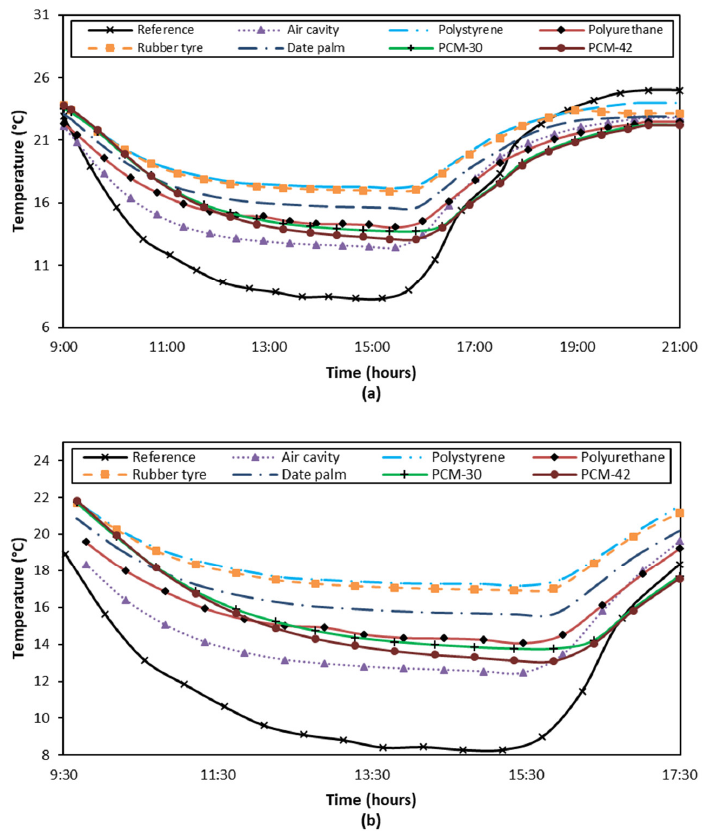
Figure 6. Thermal performance curves for back surface, ( a ) from start to end and ( b ) at the steady state. Steady state temperatures for front and back surfaces during testing of hot and cold climatic conditions are summarized in Table 2 for succinct